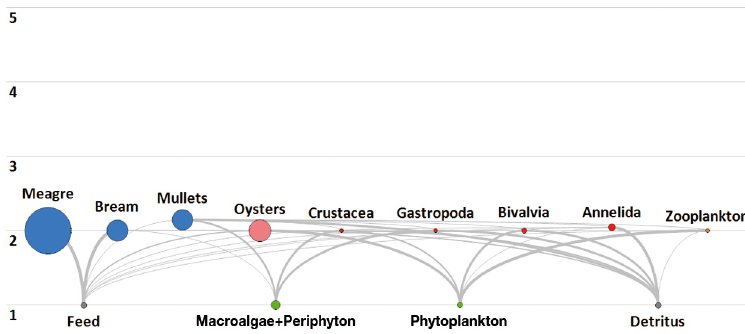
Fig. 1. Food web structure in the fish, oysters and macroalgae (FOM) treat- ment model. The 3D volume represented by each circle is proportional to the average biomass of the functional group. Numbers = trophic levels. Blue: fish; pink: oysters; red: macroinvertebrates; orange: zooplankton; green: primary producers; grey: detritus groups